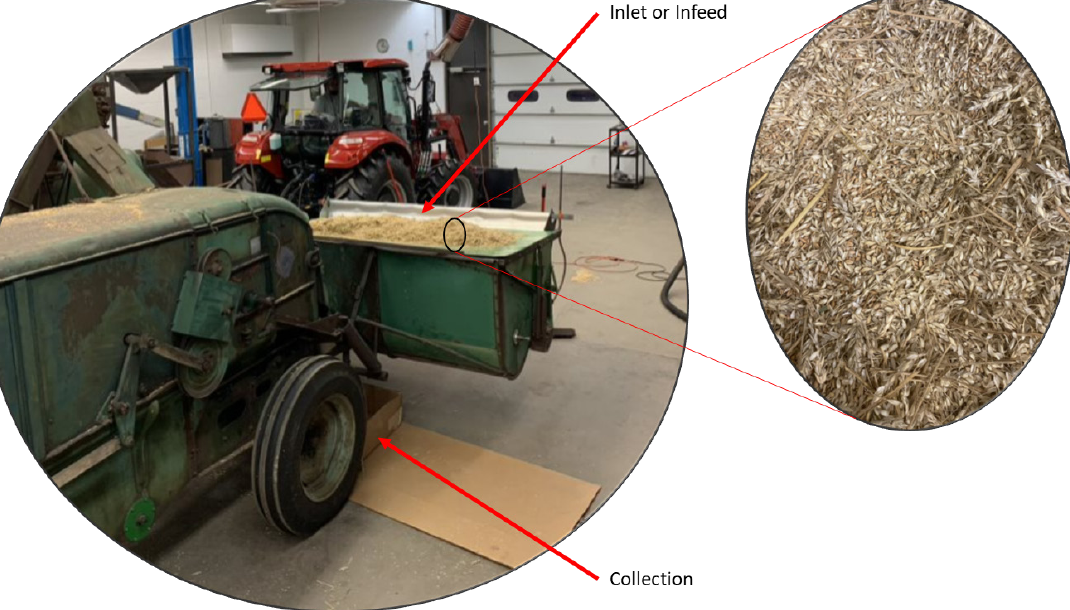
Figure 7. Combine in testing configuration with the grain-material-other-than-grain mixture.